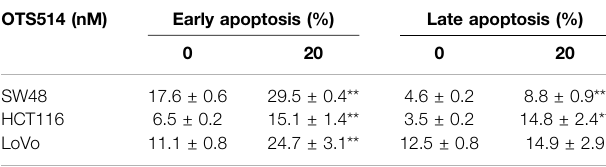
TABLE 2 | Annexin-V Assay in OTS514-treated colorectal cancer